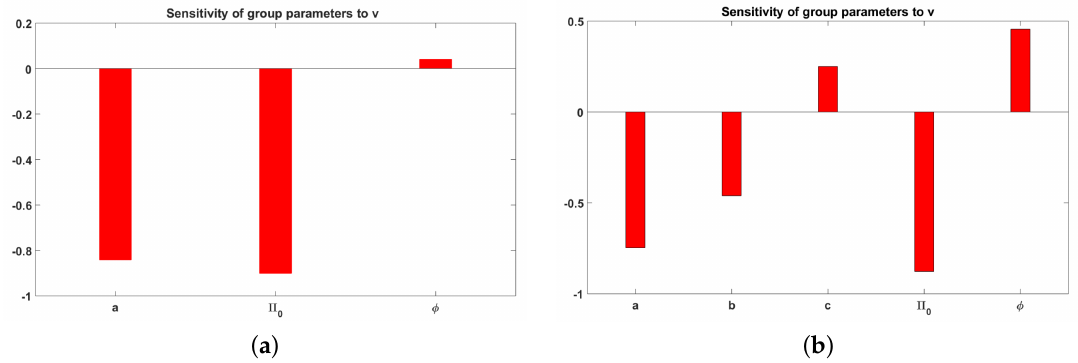
Figure 1. A depiction of the sensitivity of the non-trivial steady state v to changes in model parameters. Baseline parameters were chosen arbitrarily to take values a = 0.1962, Π 0 = 0.9419, φ = 0.7043, b = 0.6, c = 0.1 and the dimensionless time t = 280 was arbitrarily chosen to ensure that in all cases the steady state had been reached. ( a ) Case 1: f ( C ) = 0. ( b ) Case 2: f ( C ) >